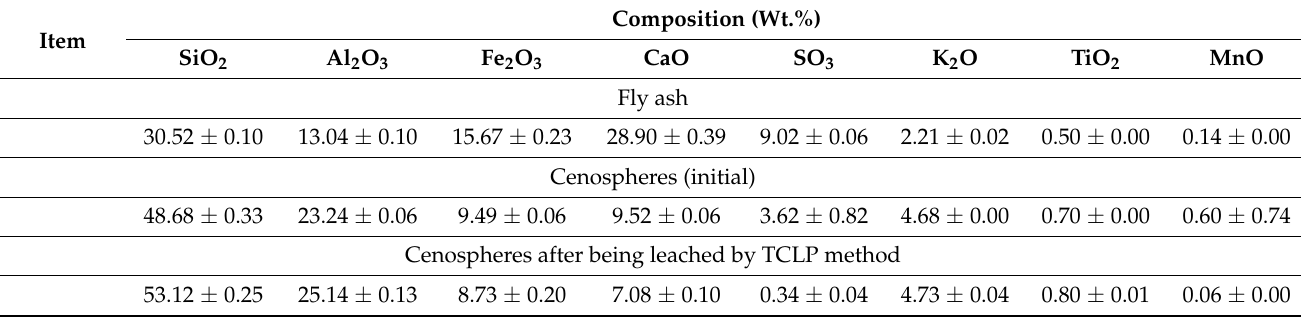
Table 2. Chemical compositions characterized by XRF of fly ash, cenospheres collected by the sink-float method using 1:10 fly ash-to-medium ratio, 2 h soaking period, and cenospheres after being leached by TCLP method. Composition Item